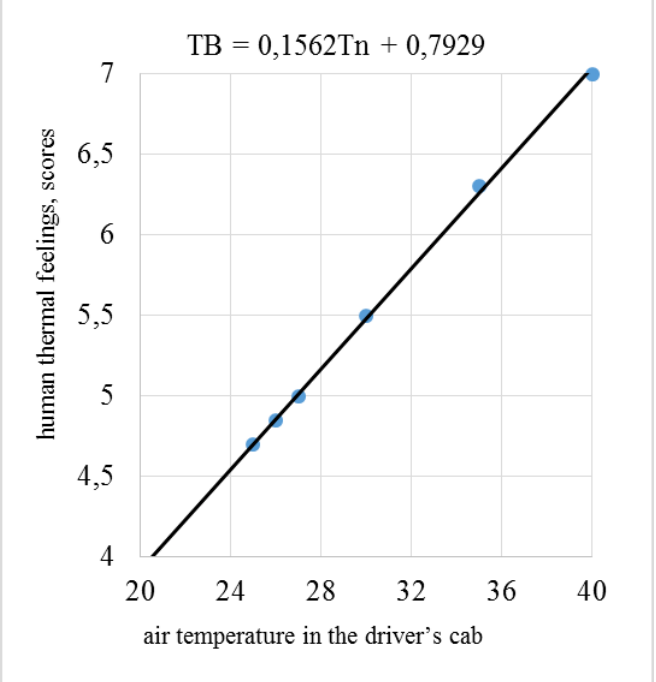
Fig. 5. Dependence of the thermal sensation on the temperature of air in the driver’s cabin in the summer: TF - human thermal feelings, scores; AT - air temperature in the driver’s cab, 0